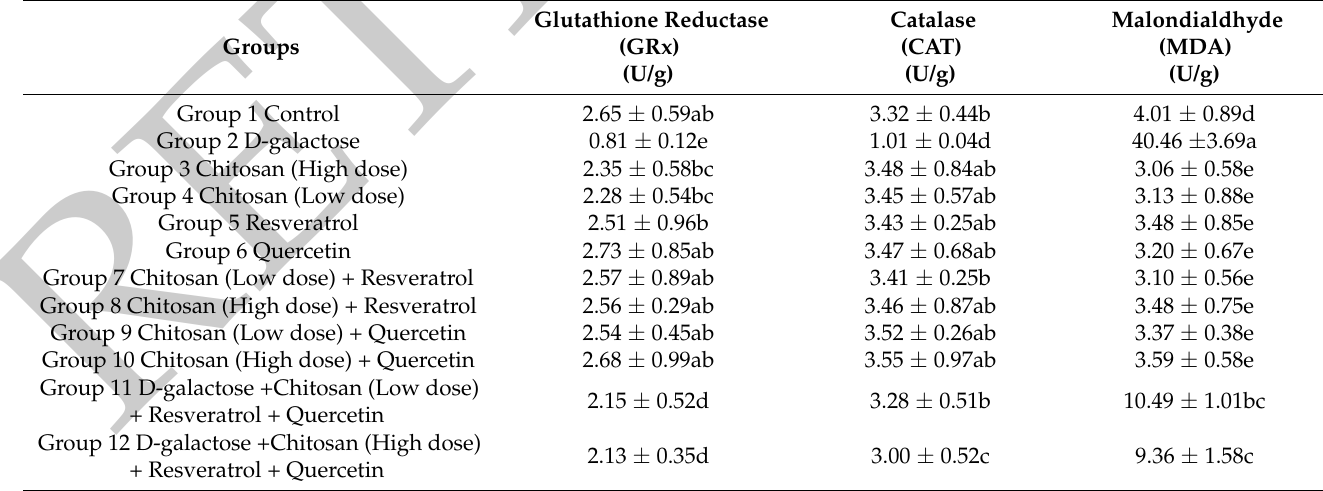
Table 2. Effect of D-galactose, Chitosan nanoparticles, Resveratrol, Quercetin, and their combinations on antioxidant enzymes: Catalase, Glutathione reductase, and Malondialdhyde (in testis homogenates) of male mice (mean ±